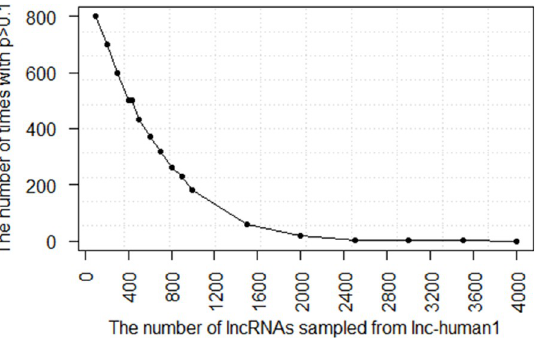
Fig 6. Relationship between the number of lncRNAs sampled from lnc-human1 and the number of times with their P > 0.1 in 1000 simulations, in which P was calculated from the Spearman correlation analysis between the half-lives of lncRNAs and their